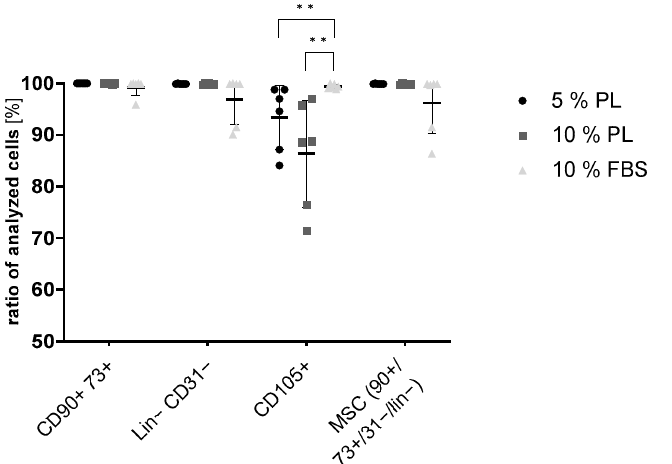
Figure 2. Flow cytometry of ADSC cultivated in 5% PL, 10% PL and 10% FBS: positive stem cell markers: CD90, CD73, and CD105; negative markers: Lin (CD34, CD11b, CD19, CD45, HLA-DR) and CD31 ( n = 6, technical triplicates, ** p ≤ 0.01).